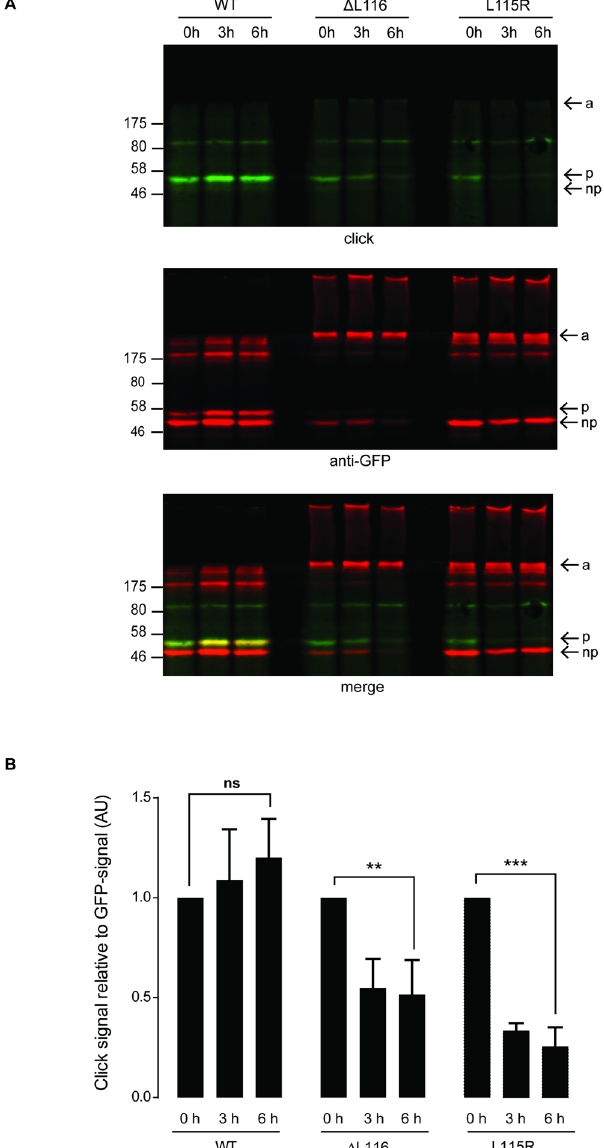
Figure 6. Palmitoylated monomers of ANCL CSP α mutants are more short-lived than wild-type protein. HEK293T cells were co-transfected with HA-zDHHC3 and wild-type, Δ L116 or L115R EGFP-CSP α for 24 hours as indicated. Cells were then labelled with 100 μ M palmitic acid azide for 4 hours. After the metabolic labelling, cells were incubated with 100 μ M unlabelled palmitic acid and 50 µ M of cycloheximide for 3 to 6 hours as indicated. Following lysis, incorporation of palmitic acid azide was detected by click reaction with IRDye 800CW alkyne. Precipitated proteins were resolved by SDS-PAGE and analysed by immunoblotting. ( A ) Representative images showing click signal from wild-type, Δ L116 and L115R CSP α ( top panel ), GFP immunoreactivity ( middle panel ) and a merge ( bottom panel ). Position of molecular weight markers are shown on the left, and the arrows indicate the aggregated ( a ), palmitoylated monomeric ( p ) and non-palmitoylated monomeric ( np ) forms of the proteins. ( B ) The graph shows quantification of palmitic acid azide incorporation into the EGFP-CSP α constructs. Quantification was performed by densitometry and is expressed as a ratio of click signal to anti-GFP signal. The calculated values of palmitic acid azide incorporation into the EGFP-CSP α constructs at 0 h were normalised to 1 for each construct and the chase values were expressed relative to this. Statistical analyses were completed with one-way ANOVA (n = 3), asterisks denote a significant difference (ns = non-significant , ** p < 0.01 , *** p < 0.001